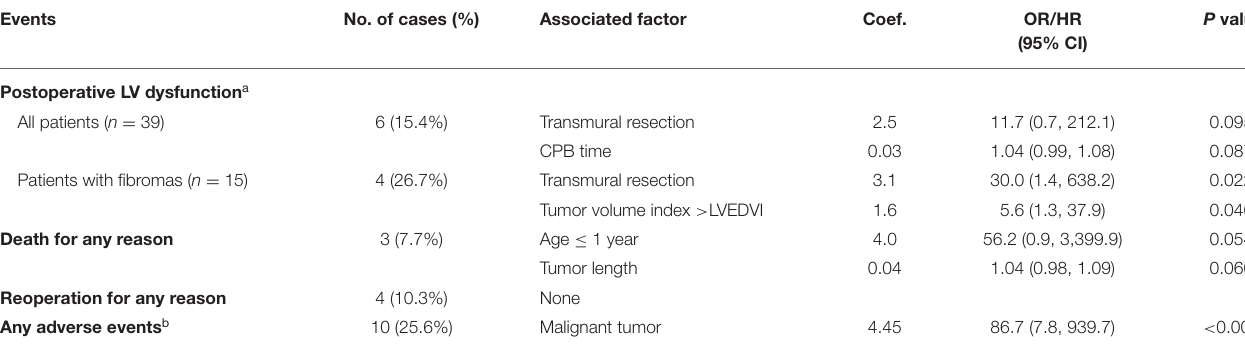
TABLE 2 | Postoperative adverse events and significantly associated factors after resection of primary cardiac tumors ( n = 39). Events No. of cases (%) Associated factor Coef. OR/HR